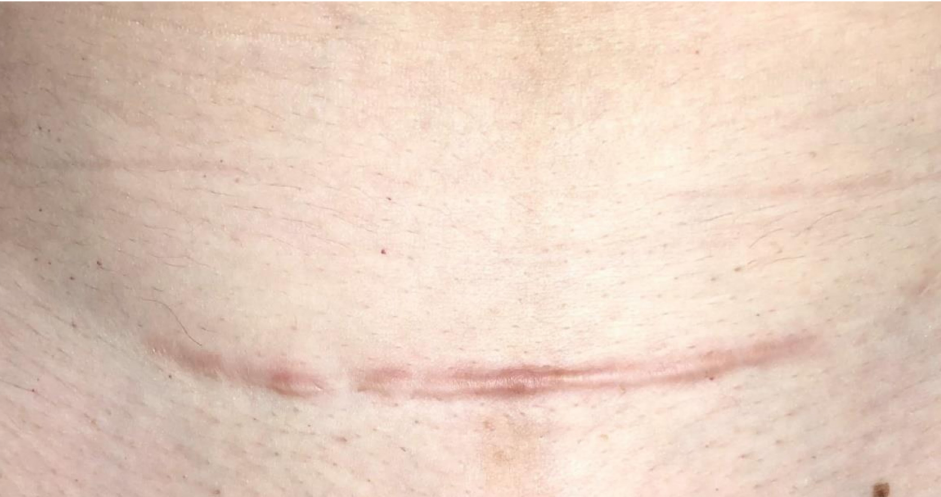
Figure 4. Hypertrophic scar after cesarean section (after 26